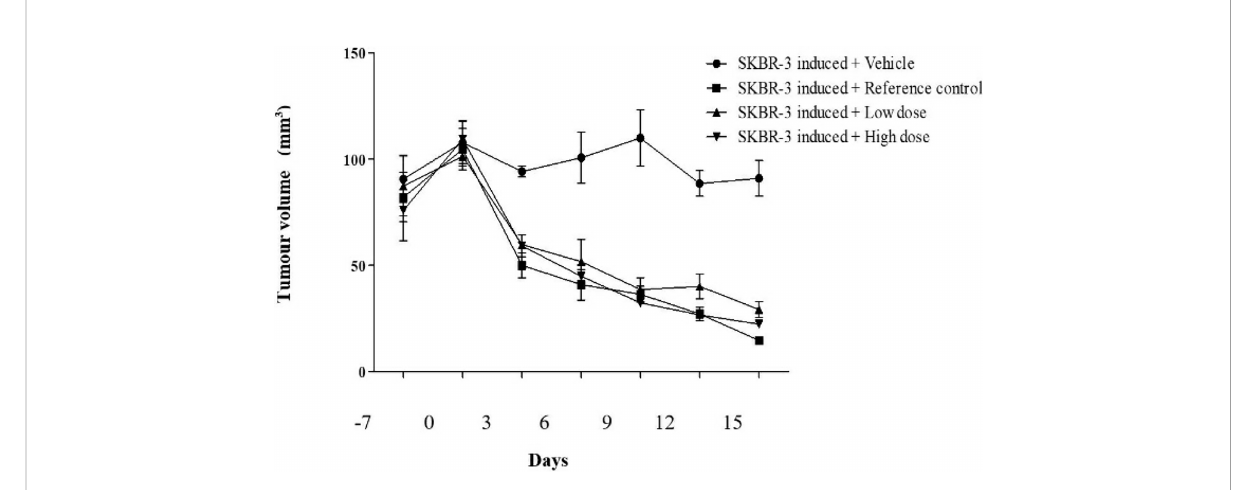
FIGURE 4 The effect of ethyl acetate extract of Spirastrella pachyspira on tumor volume of athymic mice bearing s.c. SK-BR-3